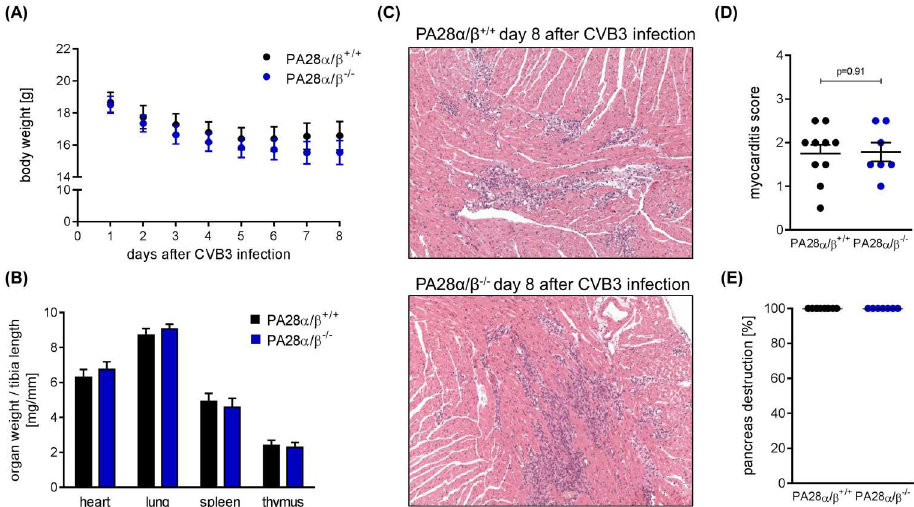
Fig 6. Investigation of PA28 αβ -/- mice during CVB3 myocarditis. PA28 +/+ and PA28 -/- mice were infected with CVB3. (A) Body weight was monitored daily and mice were sacrificedat day 8 post infection (means ± SEM). (B) Heart, lung, spleen and thymus weight was determinedand normalized to the respective tibia length (means + SEM). (C) Representative haematoxylin/eosin(HE) stainingof cardiac tissue sections obtained from CVB3-infected PA28 +/+ (n = 10) and PA28 − / − (n = 7) mice are shown. (D) Myocardialdamage comprisingcardiaccell necrosis, inflammation, and scarring was quantifiedapplyinga myocarditis score from 0 to 4 [36]. (E) The severity of pancreastissue destruction uponCVB3 infectionwas rated on a scale from 0% to 100%on HE stains of pancreatic tissue